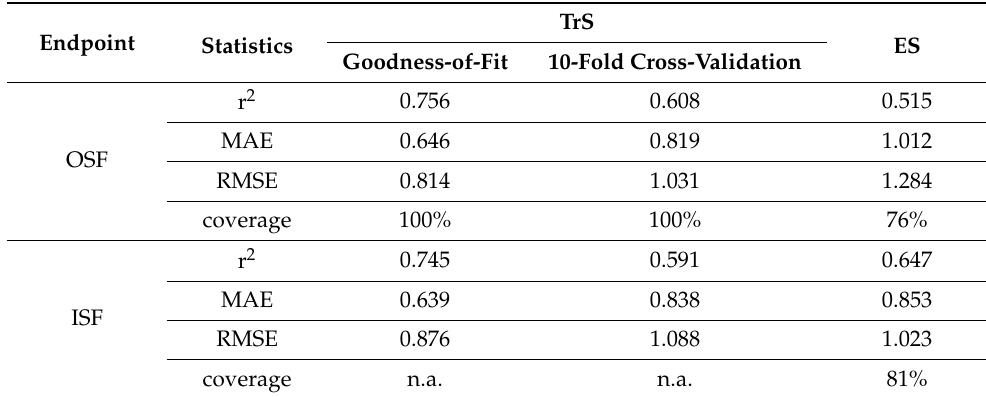
Table 3. Performance of OSF and ISF regression models derived with split scheme B. Coverage is the percentage of compounds retained after applying the applicability domain